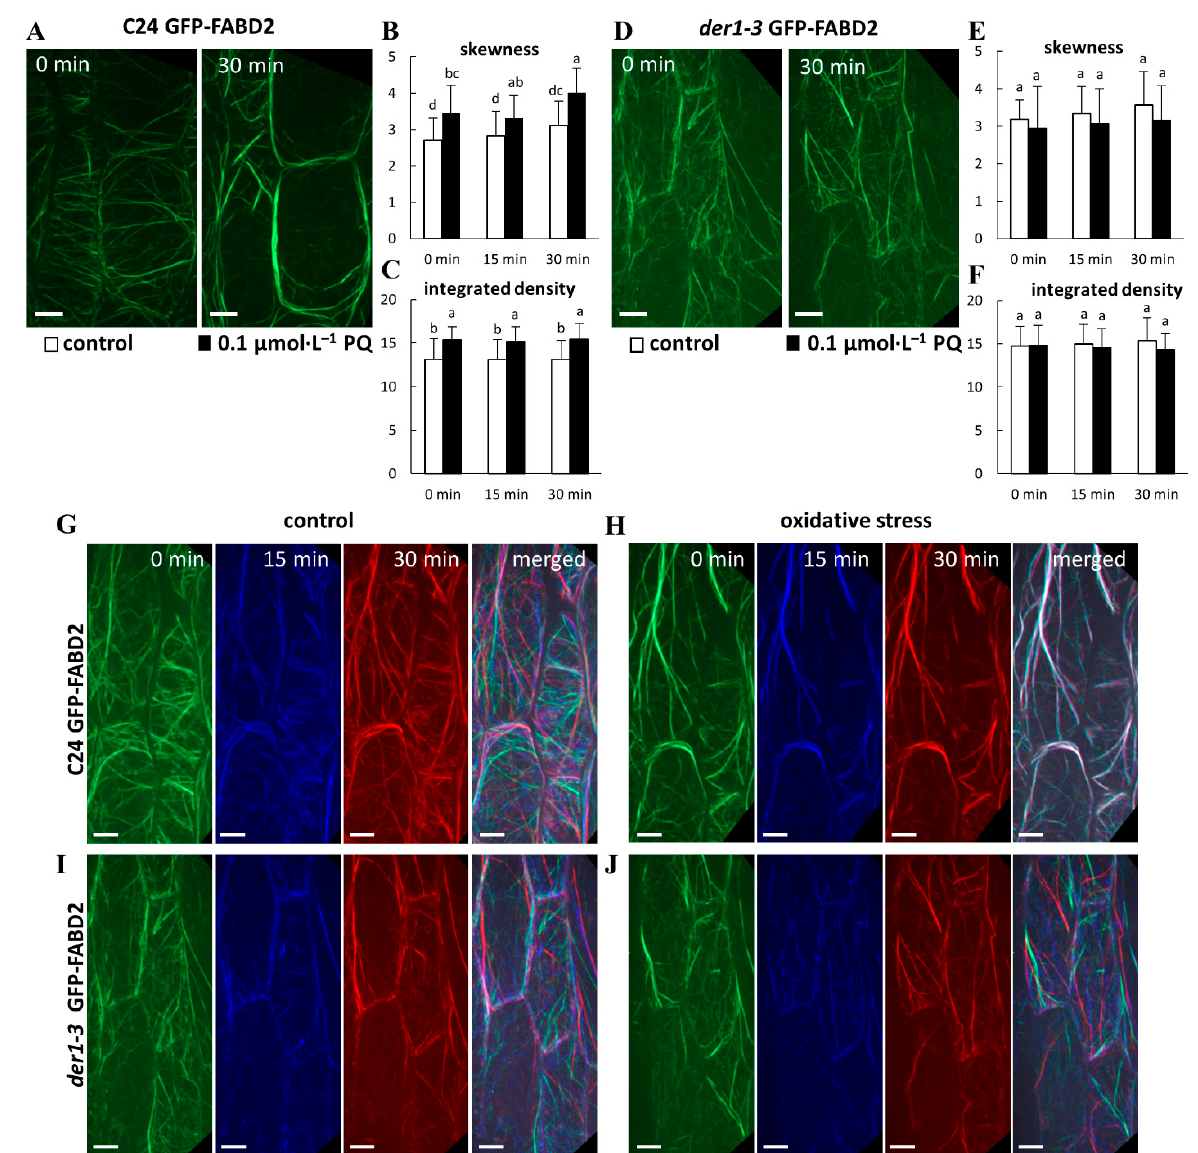
Figure 6. Organization and dynamics of actin filaments in the hypocotyl epidermal cells of transgenic C24 and der1–3 lines expressing pro35S::GFP:FABD2 under PQ-induced oxidative stress. ( A – C ) Actin filaments in hypocotyl epidermal cells of 3-day-old plants of the C24 GFP-FABD2 line in control conditions and after treatment with 0.1 µmol·L − 1 of PQ for 30 min ( A ). Quantitative analysis of the actin filament bundling extent (skewness, B ) and the actin filament density (percentage of occupancy, C ) in control conditions and after the application of 0.1 µmol·L − 1 of PQ. ( D – F ) Actin filaments in the hypocotyl epidermal cells of 3-day-old plants of the der1–3 GFP-FABD2 line in control conditions and after treatment with 0.1 µmol·L − 1 of PQ for 30 min ( D ). Quantitative analysis of the actin filament bundling extent (skewness, E ) and the actin filament density (percentage of occupancy, F ) in control conditions and after the application of 0.1 µmol·L − 1 of PQ. Data were analyzed on images collected from hypocotyl epidermal cells within 0, 15 and 30 min time-points of scanning. ( G – J ) Semiquantitative analysis of actin filament dynamics in hypocotyl epidermal cells presented by pseudocoloring displace- ment analysis. Dynamic properties of actin filaments in the C24 GFP-FABD2 line in control conditions ( G ) and after the application of 0.1 µmol·L − 1 of PQ ( H ). Dynamic properties of the actin filaments in the der1–3 GFP-FABD2 line in control conditions ( I ) and after the application of 0.1 µmol·L − 1 of PQ ( J ). Images acquired at the beginning, after 15 min and after 30 min of time-point scanning were colored red, green, and blue, respectively, and merged. A white color indicates low- ering (eventually stopping) of the actin dynamic activity. Experiments were repeated 5–6 times with 4–5 cells per plant in each line. Different lowercase letters above the bars ( B , C , E , F ) represent statistical significance according to one-way ANOVA and subsequent LSD test at p value <0.05. Scale bar = 10 µm.